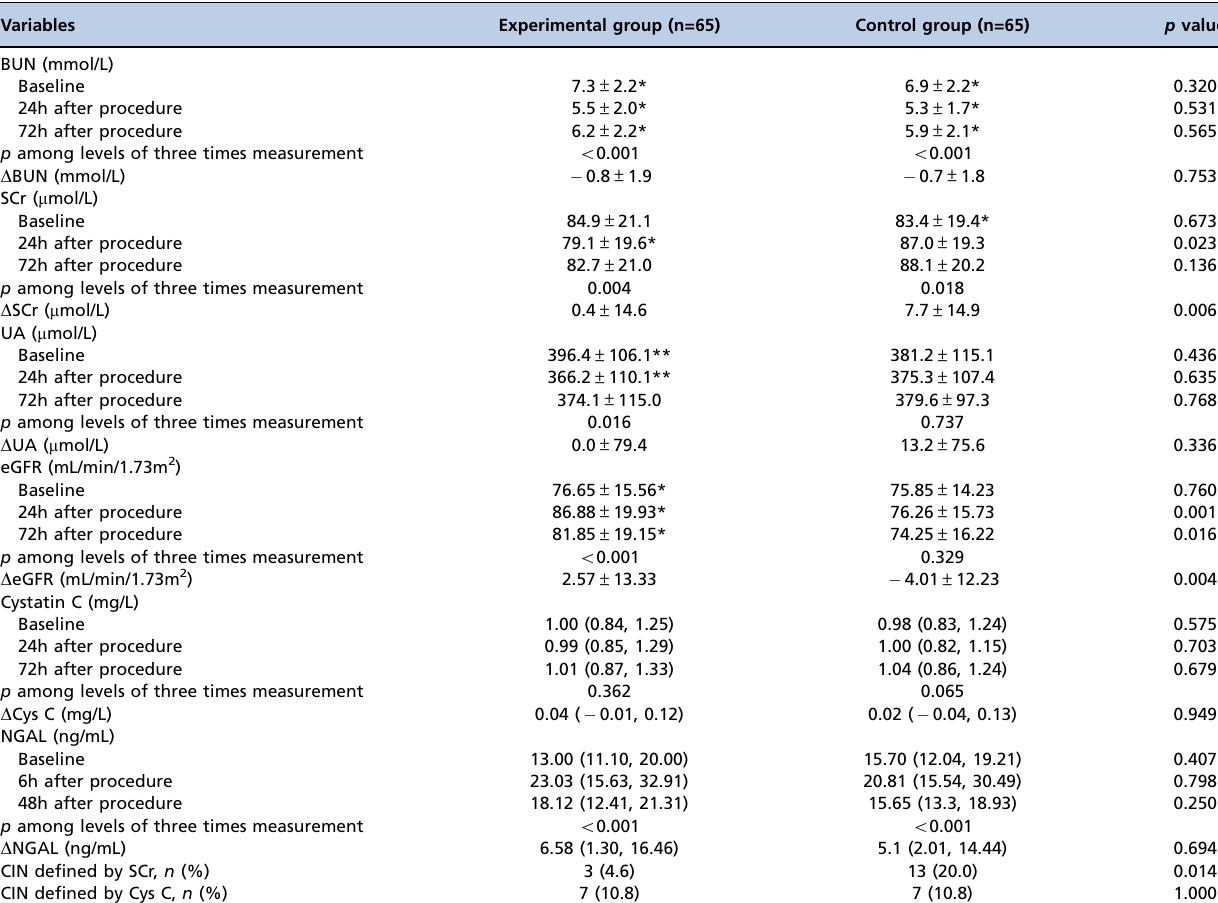
Table 3 - Comparison of renal function biomarkers between two